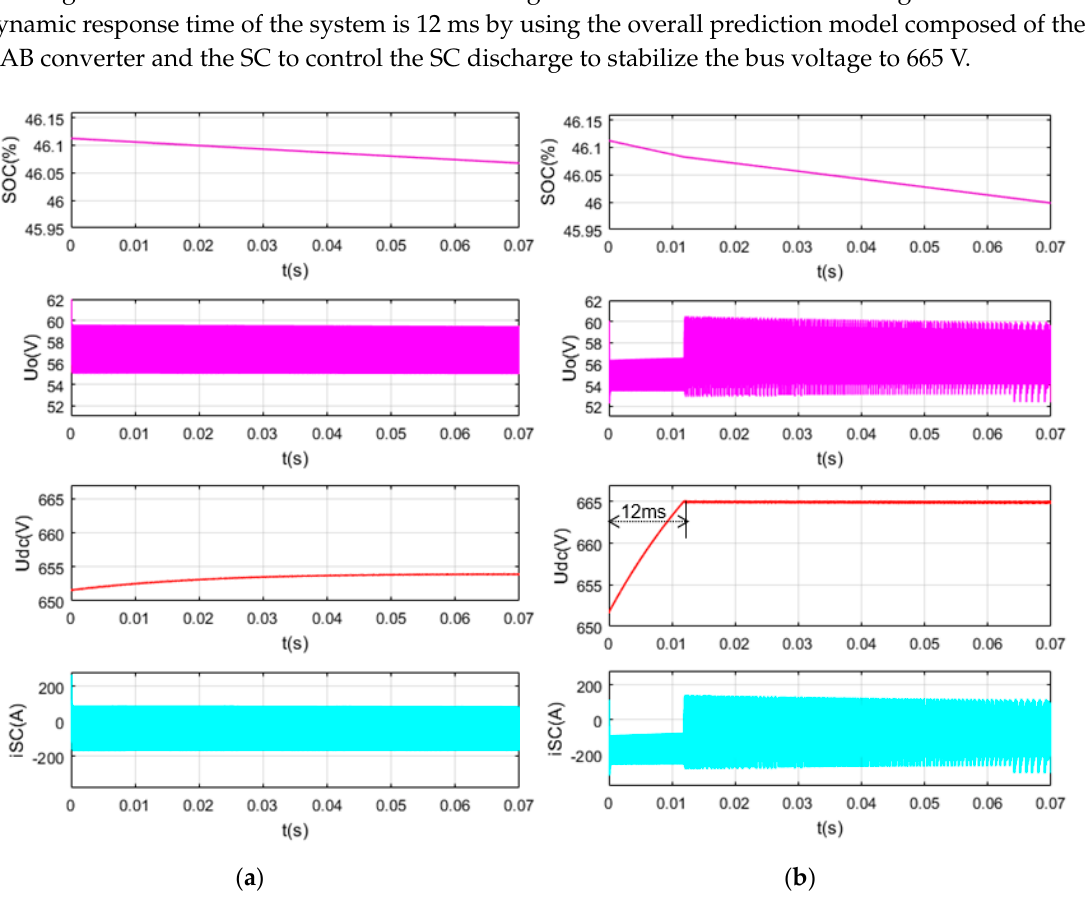
Figure 11. Simulation waveform diagram when the initial voltage, U dc , is 651.7 V and the initial voltage, U o , is 58 V: ( a ) MPC only for the DAB; ( b ) MPC for the DAB-SC system.